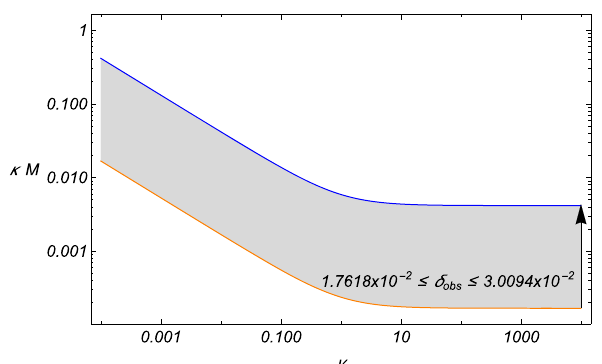
Fig. 2 The relation between γ and M , where n = 2 and N = 60. The δ increases along the direction of the arrow